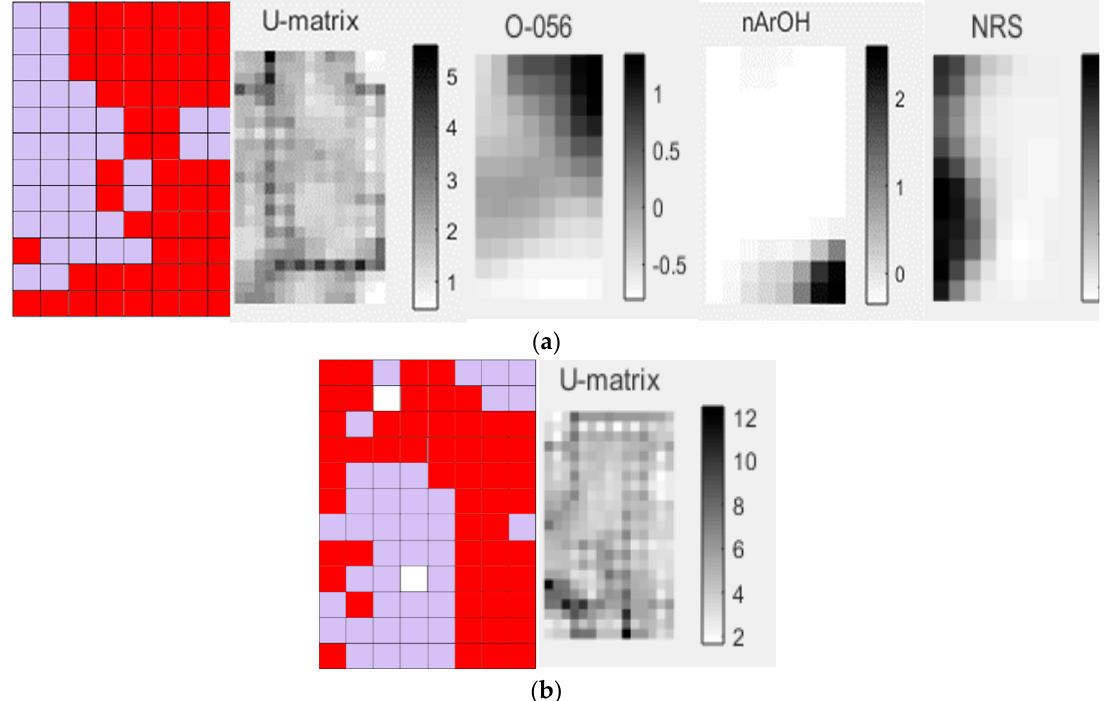
Figure 2. Self-organizing map obtained by classification of the subfamilies of clade III (red) and clade IV (lilac) and generated descriptors: ( a ) SOM  molecular descriptors; U-matrix; O-056, nArOH and NRS. ( b ) SOM  fingerprint and